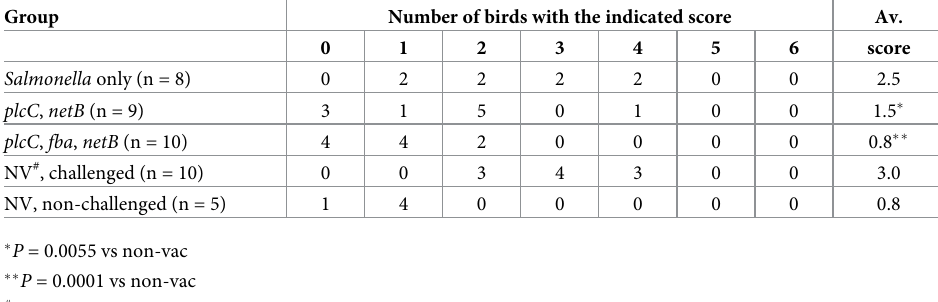
Table 3. Intestinal lesion scores from Experiment 1. Group Number of birds with the indicated score